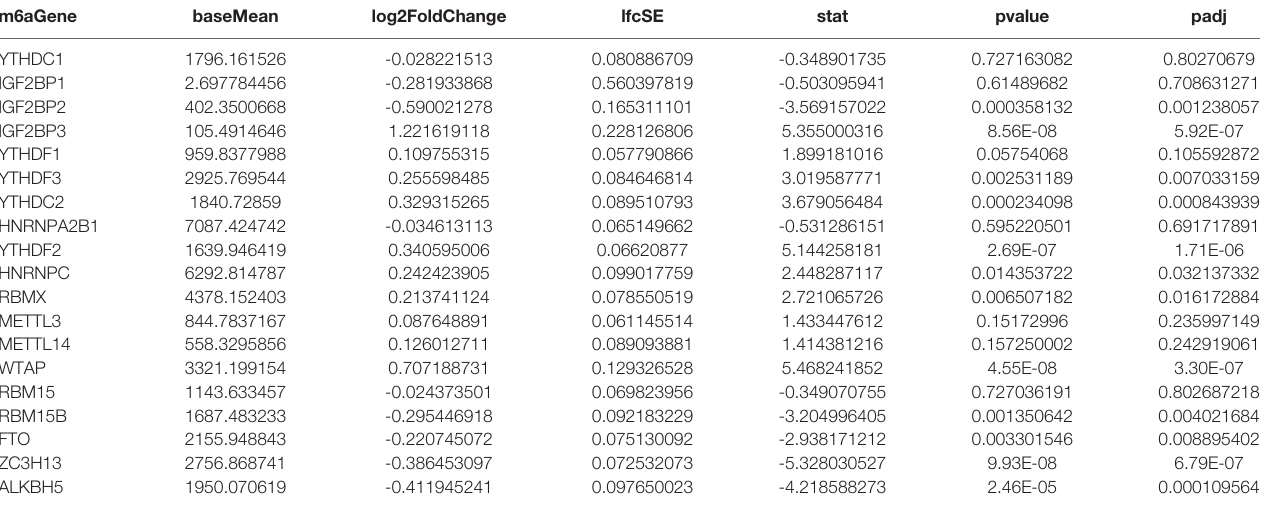
TABLE 3 | Differential analysis of m6a-related